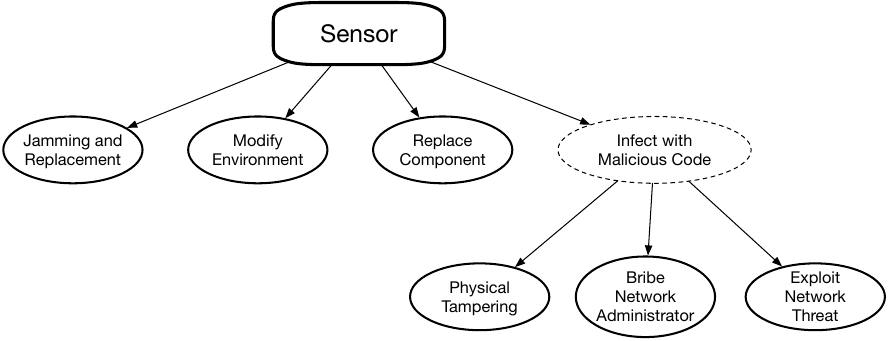
Figure 2. Attack tree for our IoT